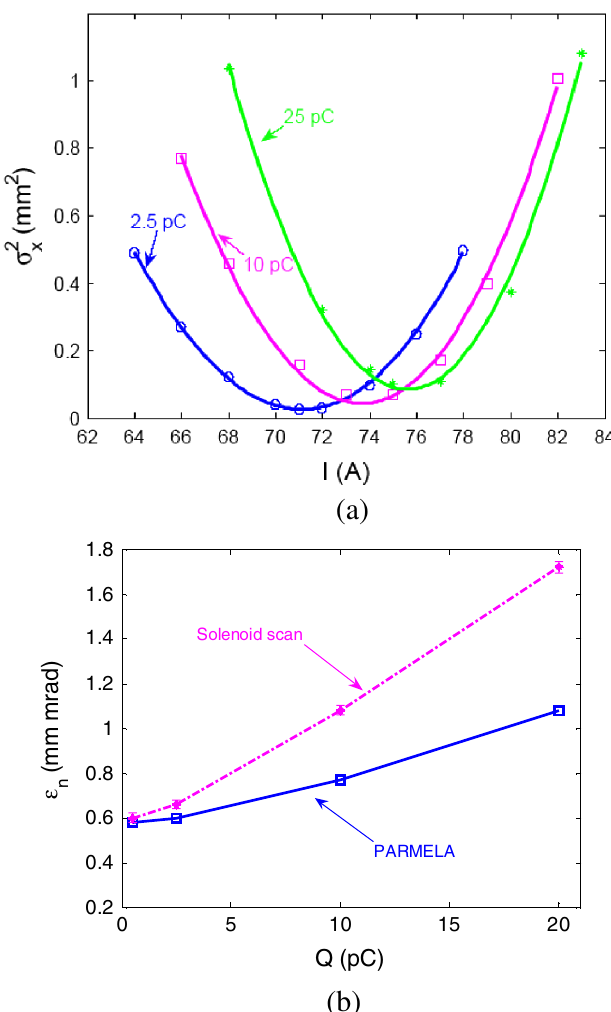
FIG. 5. (Color) (a) Beam sizes at the YAG screen for various beam charges and the corresponding curve fitting. (b) Emittance results from PARMELA simulation and that from the solenoid scan method for various beam charges.